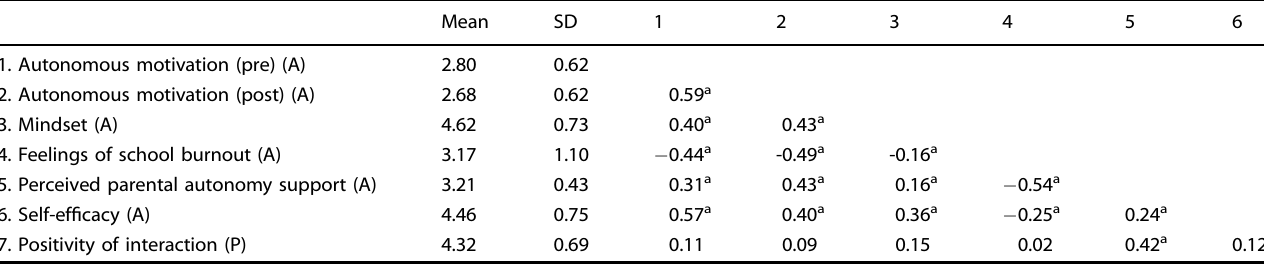
Table 1. Mean, standard deviations and correlation of the different measurements parent-adolescent dyads ( N = 76 parent-adolescent